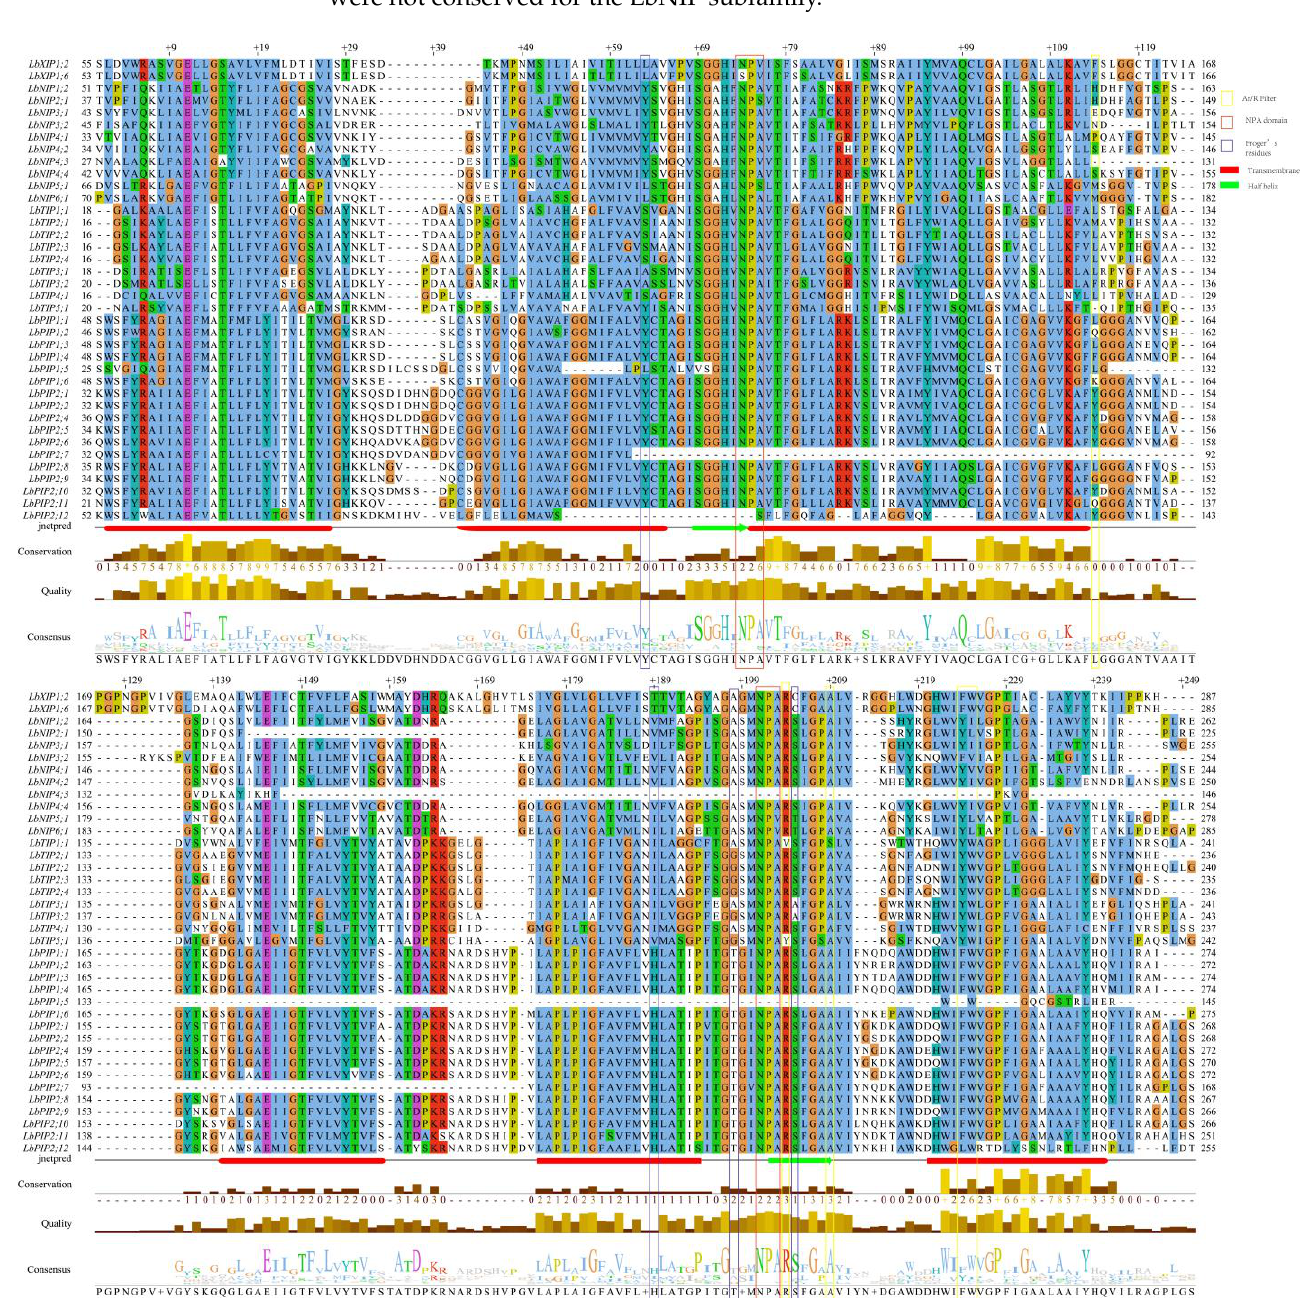
Figure 4. Protein sequence alignment of LbAQPs. Conserved transmembrane domains (TM1-6) and amino acids at NPA domains, ar/R selectivity filters, and Froger’s residues identified in LbAQPs.